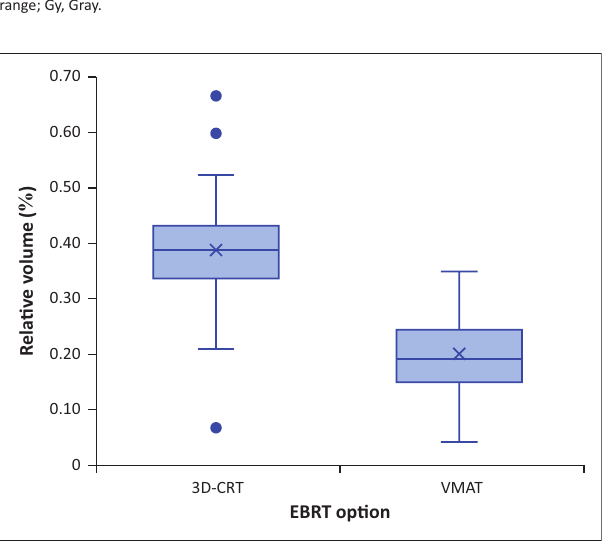
FIG URE 2: Box and whisker plot comparing bone marrow relative volume at 40 Gy.